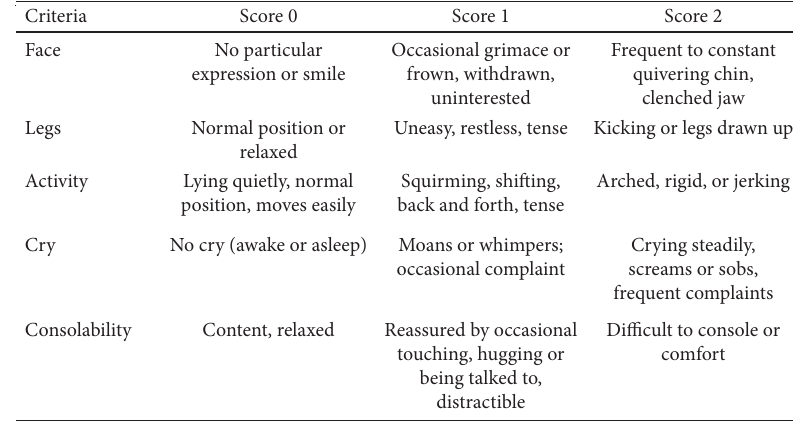
Figure 4: FLACC scale for pain assessment from child behavior (score